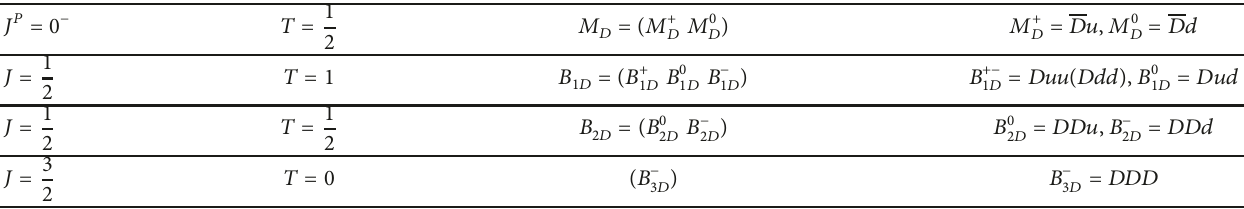
Table 2: Characteristics of 𝐷 -type